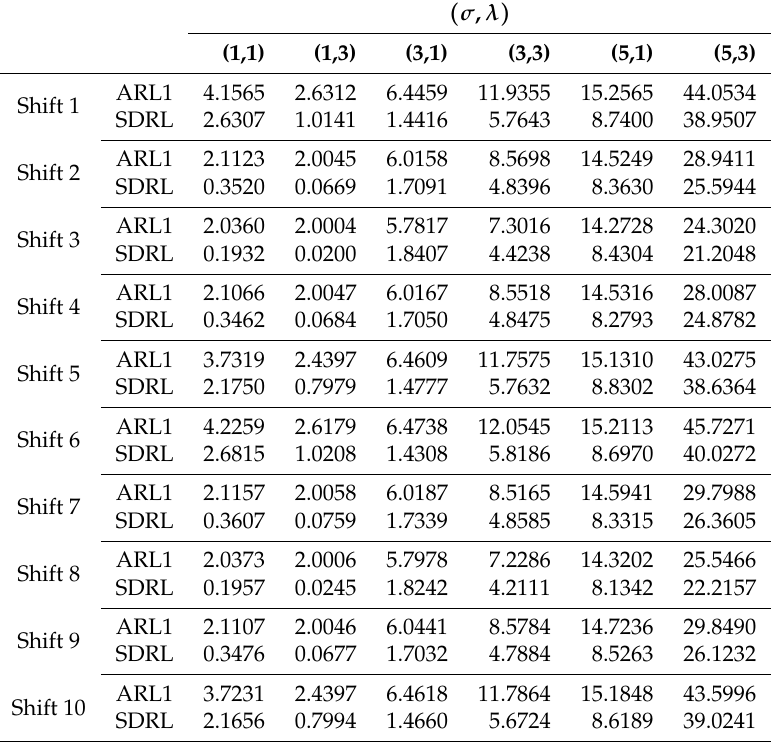
Table 2. The ARL 1 and SDRL of the MS-MAE chart for different combinations of σ , λ and ξ =